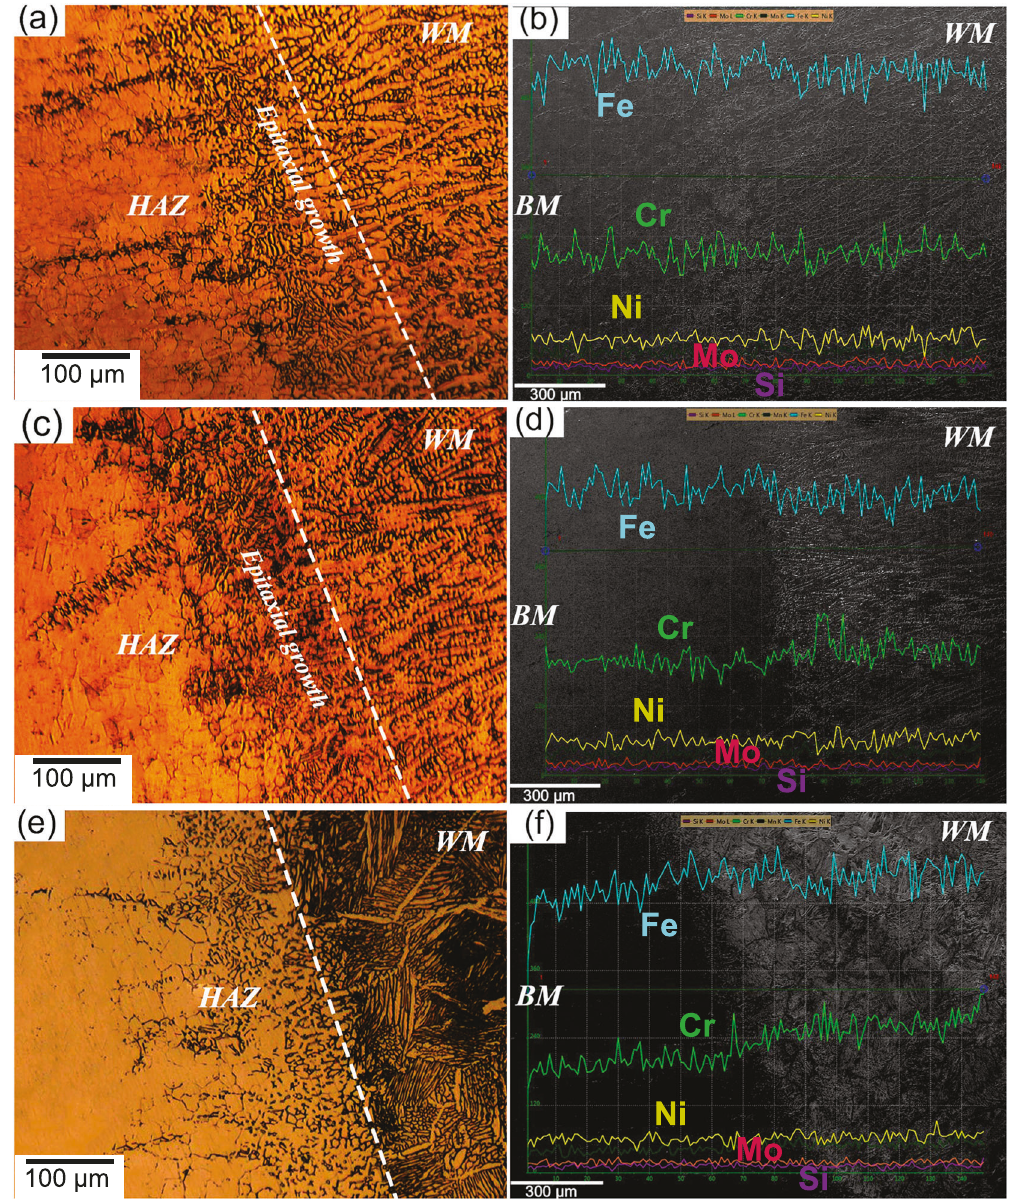
Fig. 3 Transition zone. LOM micrograph and EDS line analysis at the interface of base metal and welds made by ( a , b ) 316 L, ( c , d ) 309 L, and ( e , f ) 312 fi ller